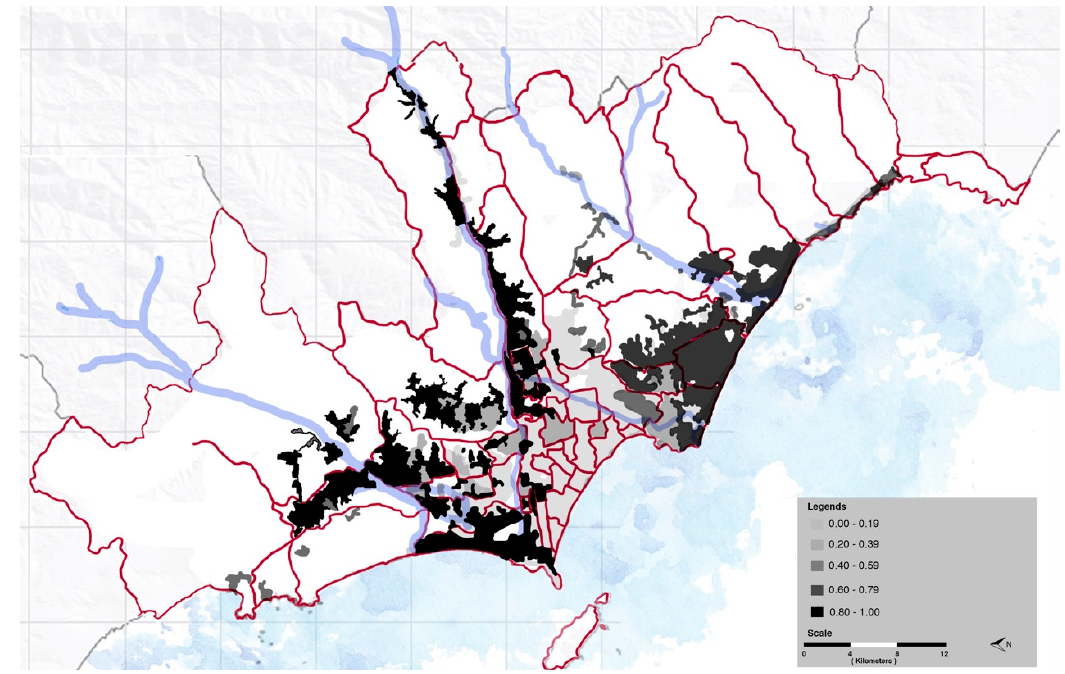
Figure 4. Distribution of low-income population in Lima in 1993. Note: Units are the proportion of low-income population according to the National Institute of Statistics and Informatics (INEI), i.e., low and very low socio-economic levels. Source: Reference [22]. Map edited by authors.